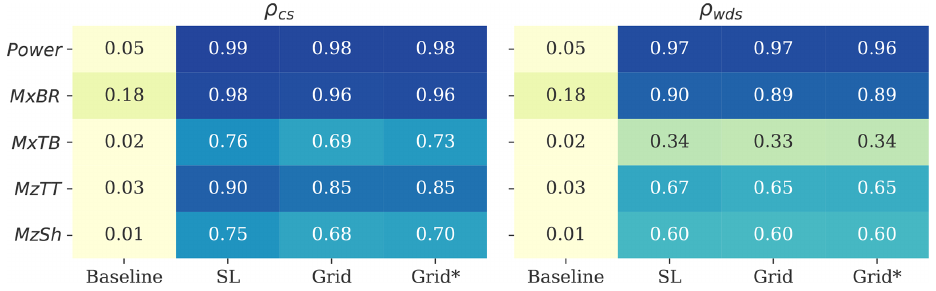
is non-zero at frequencies of up to 0.7 Hz (6P) and is